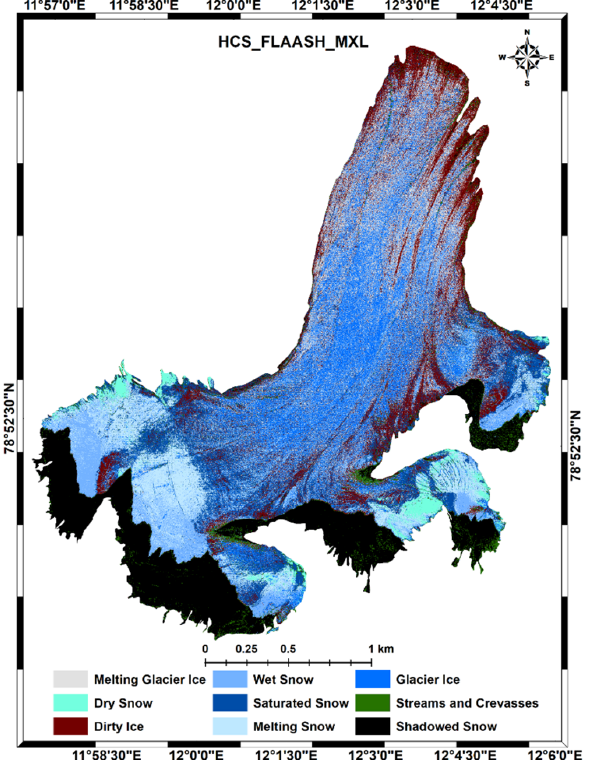
Figure 8. Thematic classification results of the MXL algorithm for the FLAASH atmospheric correction for the ST glacier.